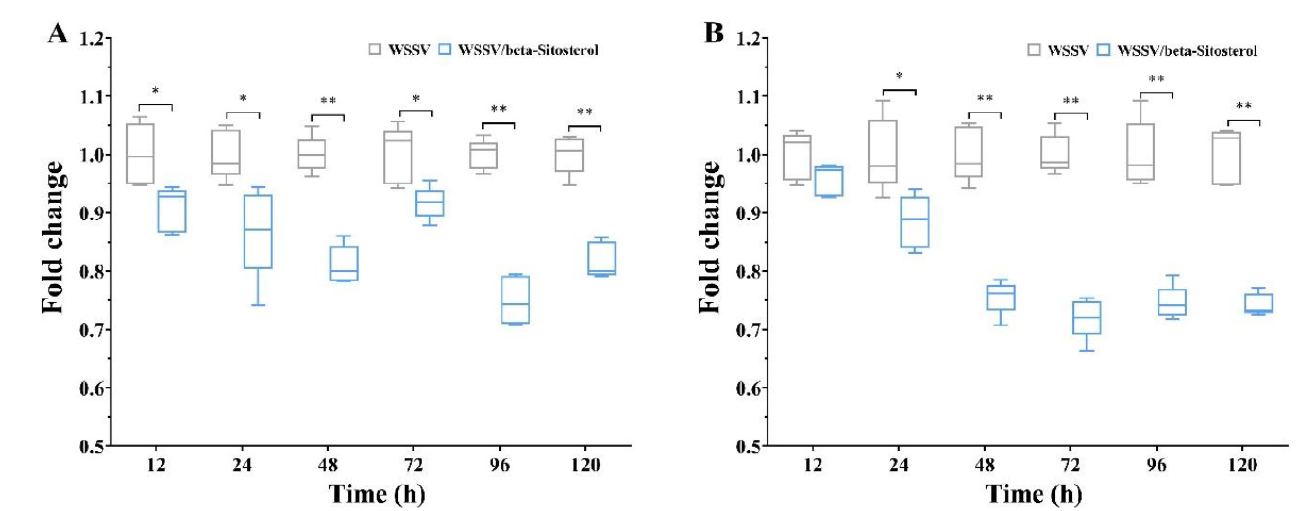
Figure 6. Beta-sitosterol (50 mg/kg) reduced total protein levels in hemolymph and gill tissues of crayfish after WSSV infection at different times (12, 24, 48, 72, 96, and 120 h). ( A ) Changes in total protein levels in gills under different treatments. ( B ) Changes in total protein levels in hemolymph under different treatments. The box plots show median value ± standard deviation and the interquartile range of likely variation (n = 5). Asterisks indicate the significant difference between the experimental and control groups (** p < 0.01, * p < 0.05).